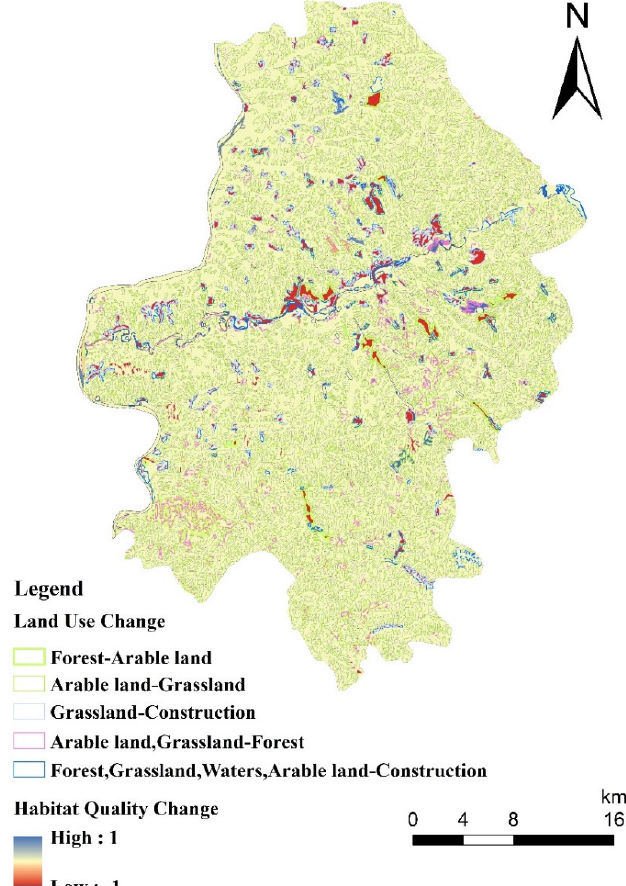
Figure 5. Habitat quality change map based on land use conversion analysis from 2000 to 2020. In the figure, the value of 0–1 represents an increase in habitat quality, and the value of − 1–0 represents a decrease in habitat quality. Different colors represent different land conversions.